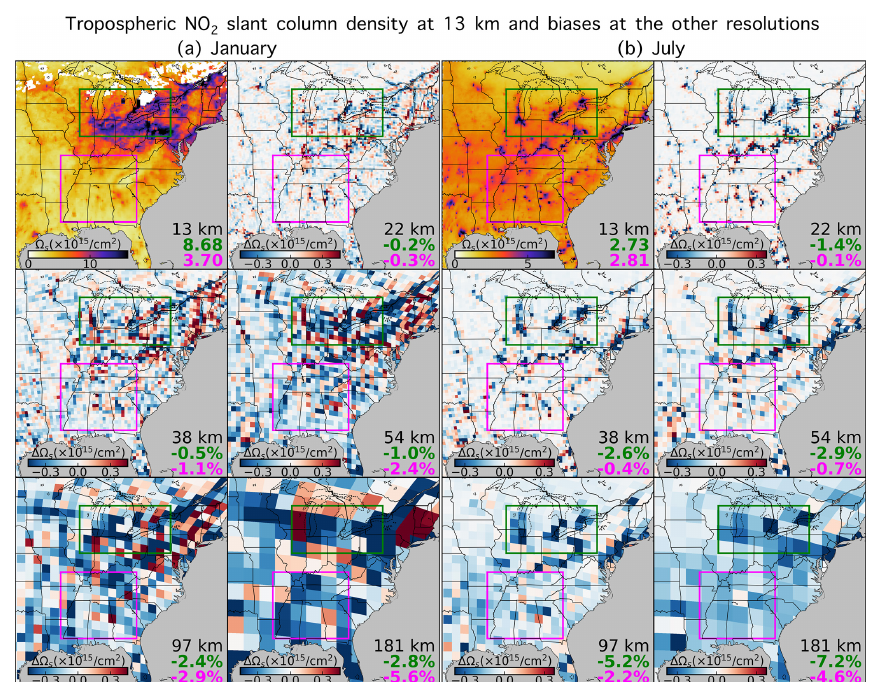
Figure A5. Similar to Fig. 7 but for slant column density ( (cid:127) s , molec.cm − 2 ) calculated from GEOS-Chem NO 2 mixing ratios and scattering weights corresponding to TROPOMI observations. The small blank (white) areas in January have no available TROPOMI retrievals under clear-sky and snow-free